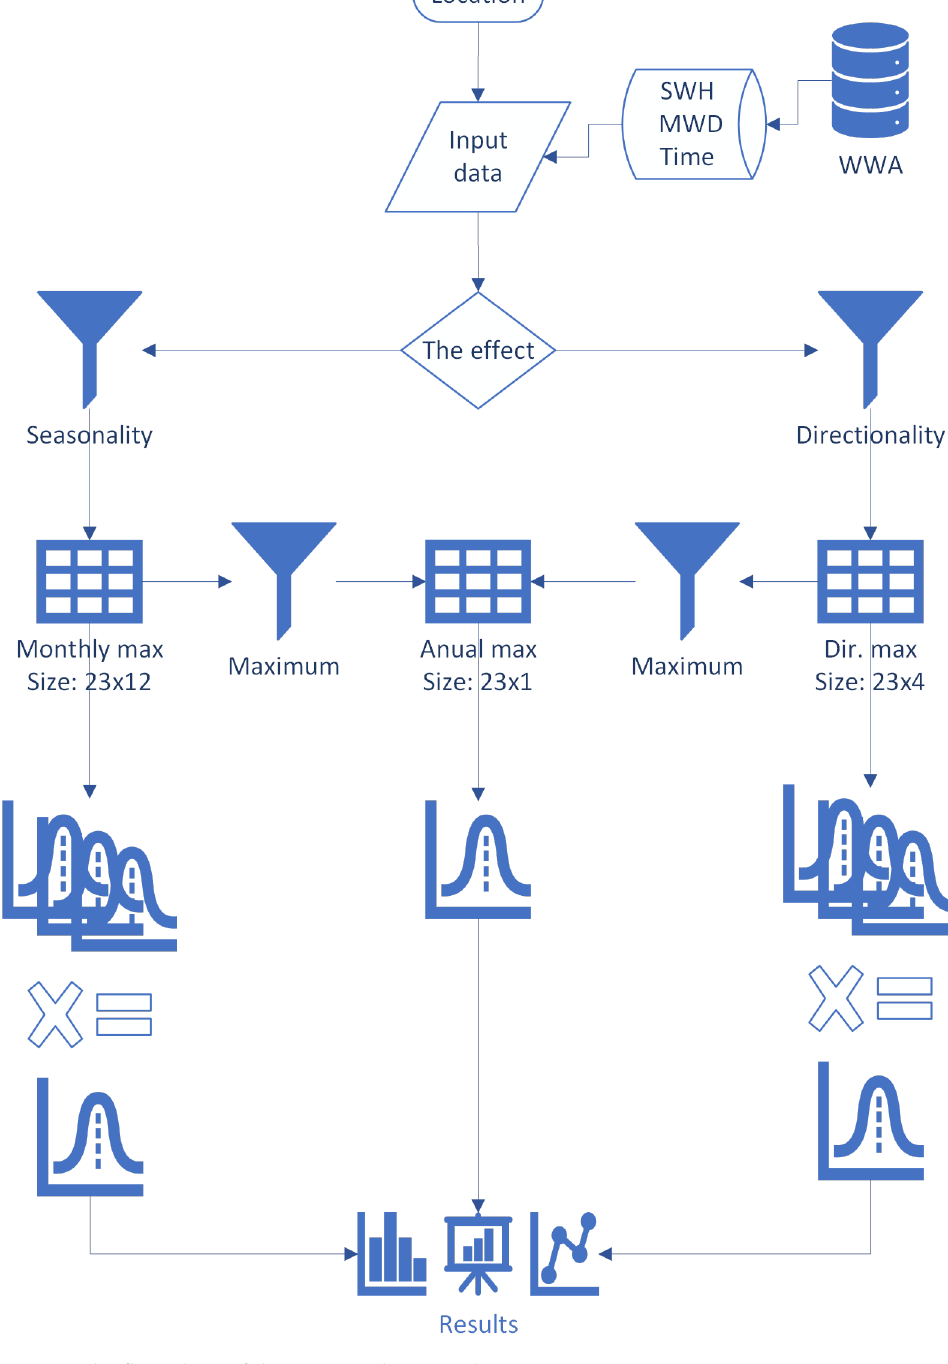
Figure 3. The flow chart of the presented approach. Parameter A , although called the location parameter, in this context represents the most probable extreme SWH, and B is the scale parameter. Gumbel PDF is fitted to 12 records of MM, 4 records of DM, and AM. Fitting of Gumbel distribution is performed by the maximum likelihood method (MLE), utilizing the scipy.stats package in Python [23]. From individual distributions of directional or monthly maxima, combined ‘annual maxima’ is calculated by the C–C method, using Equation (3)